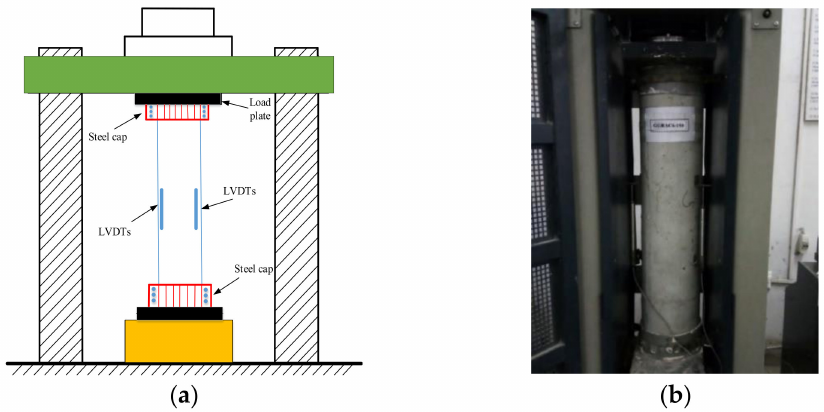
Figure 4. Testing of compressive members in the present study: ( a ) schematic diagram ( b ) experi- mental